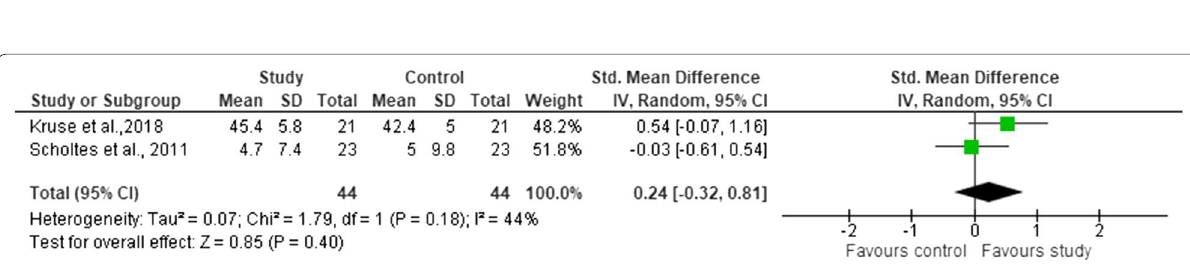
Fig. 4 Forest plot of comparison between study and control groups regarding plantar flexion angle — follow-up